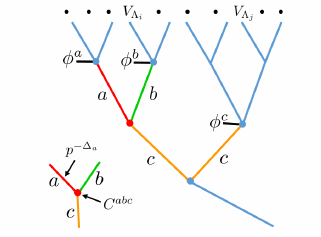
Figure 1 . The tensor network representation of a p = 2 -adic CFT. The diagram depicts three bulk operator insertion. When these bulk insertions are pushed to the asymptotic boundary they are equivalent to boundary insertions. The boundary condition V point tensor V a = δ a . Each vertex tensor is given by C abc and each edge of the tensor with index 1 f a is weighted by p − ∆ a